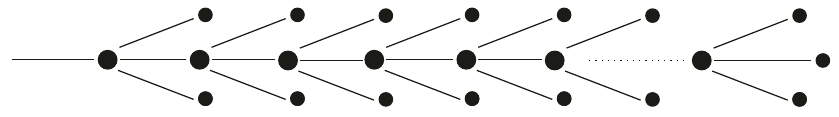
Figure 4: The molecular structure of 𝑅 𝑖 : alkyl.